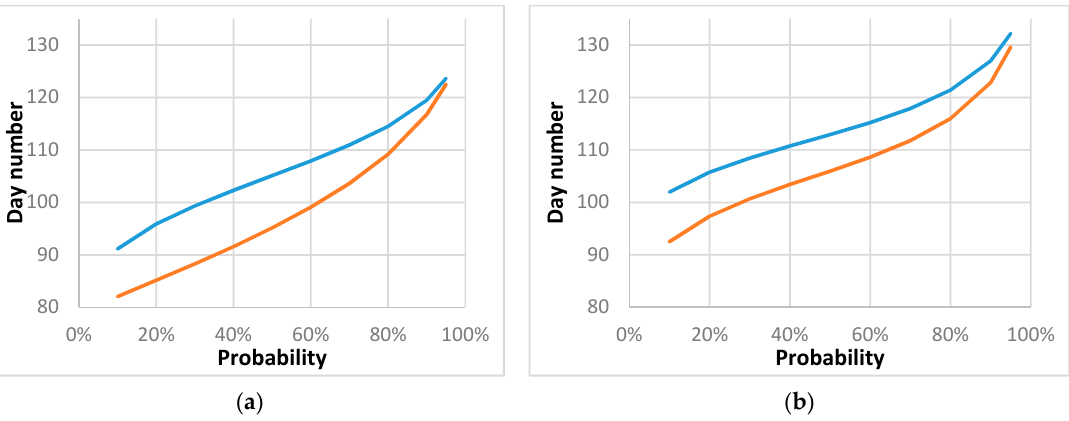
Figure 5. The probability curves of the last spring frost event described by a calendar day number (Tmin < − 1 °C) in the period of 1961–1990 (blue line) and 1991–2020 (orange line). ( a ) Sandomierz ( b ) Poznan.